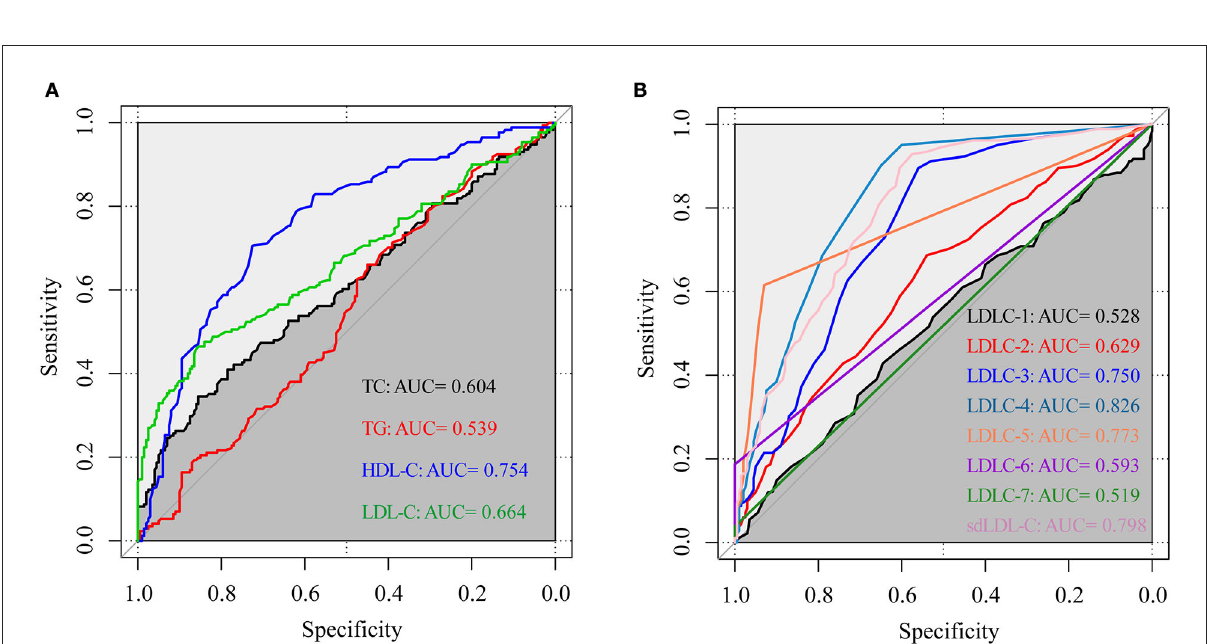
FIGURE4 The ROC curve of blood lipids to distinguish patients with CAD from non-CAD controls. (A) TC, TG, HDL-C, and LDL-C; (B) LDL-C subfractions (LDLC-1 to LDLC-7) and sdLDL-C. ROC curve, receiver operator characteristic curve; AUC, area under the curve; TC, total cholesterol; TG, triglyceride; HDL-C, high-density lipoprotein cholesterol; LDL-C, low-density lipoprotein cholesterol; sdLDL-C, small dense low-density lipoprotein